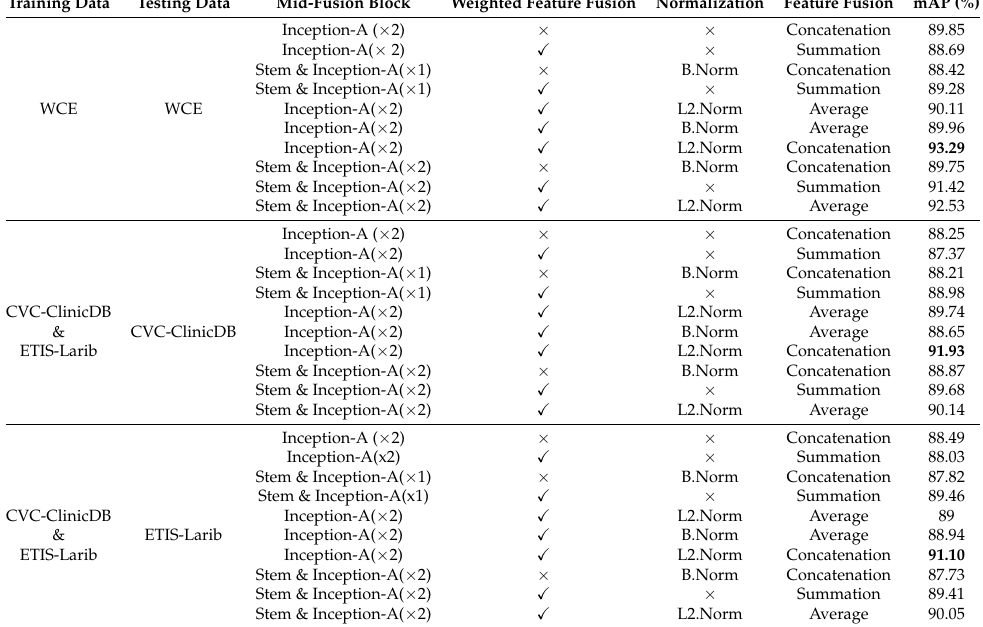
Table 1. Effects of different design factors of the mid-fusion block on the Hyb-SSDNet performances. The mAP is measured on the WCE, CVC-ClinicDB, and ETIS-Larib test sets. Training